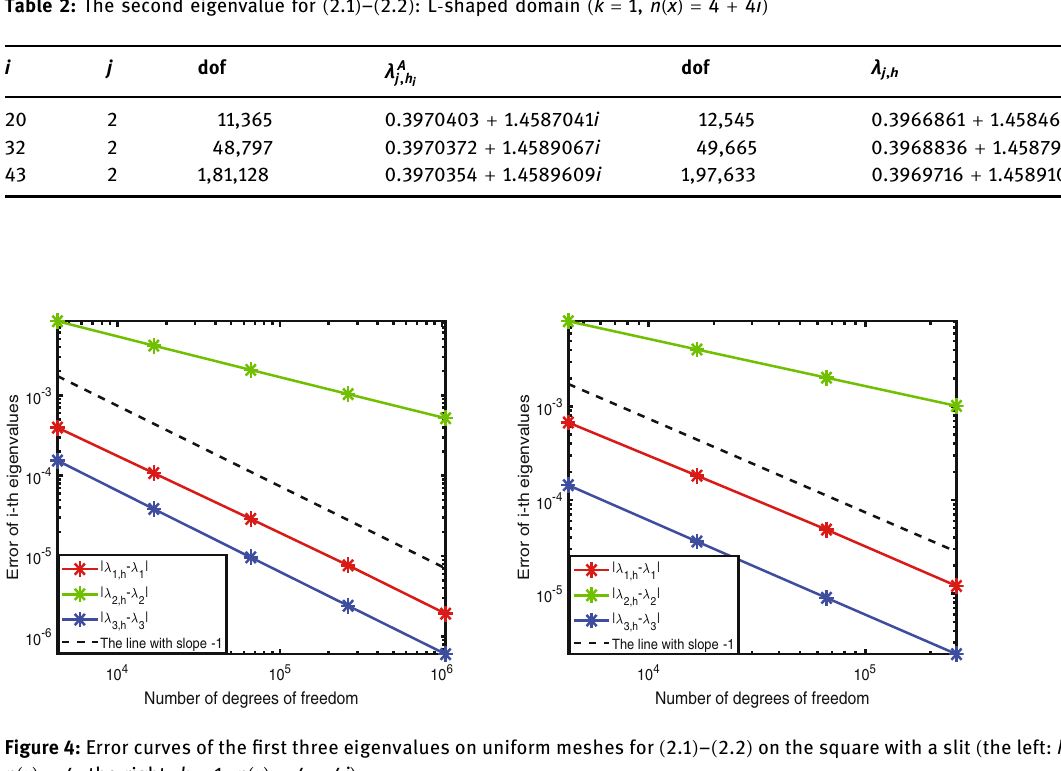
Figure 4: Error curves of the fi rst three eigenvalues on uniform meshes for ( 2.1 ) – ( 2.2 ) on the square with a slit ( the left: k = 1, n ( x ) = 4, the right: k = 1, n ( x ) = 4 + 4 i ) .